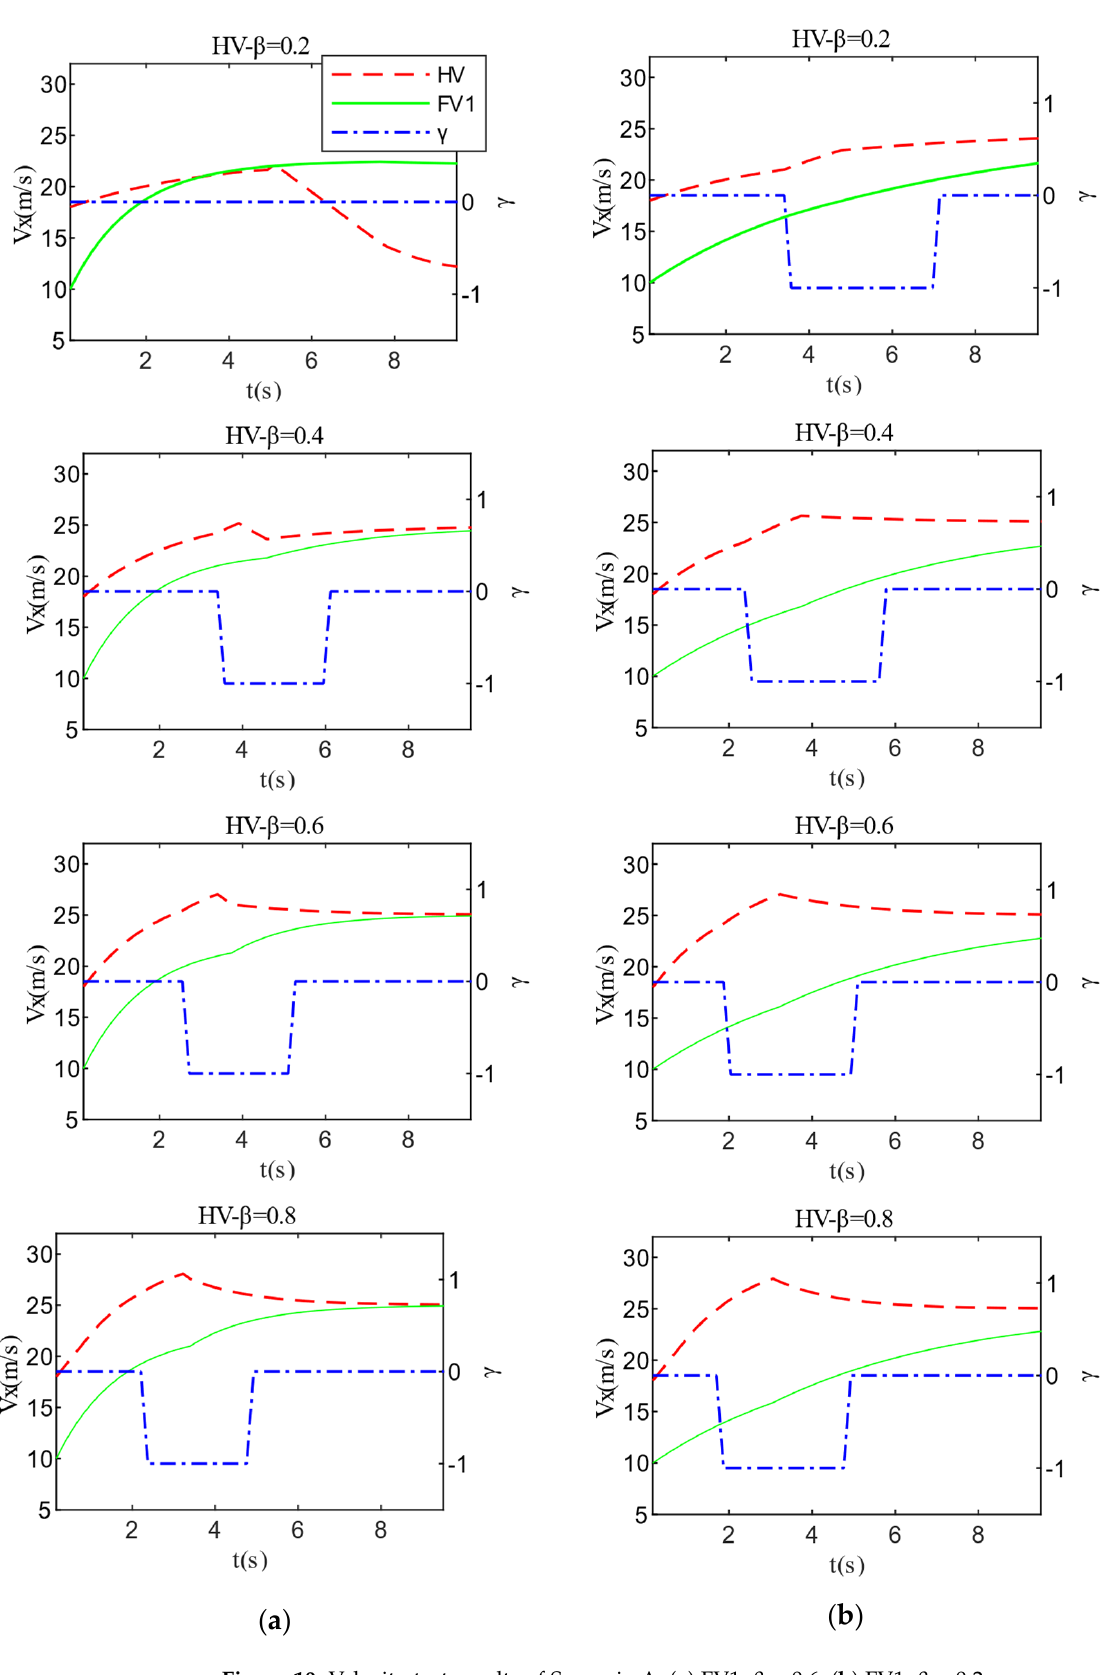
Figure 10. Velocity test results of Scenario A: ( a ) FV1_ β = 0.6; ( b ) FV1_ β = 0.2.